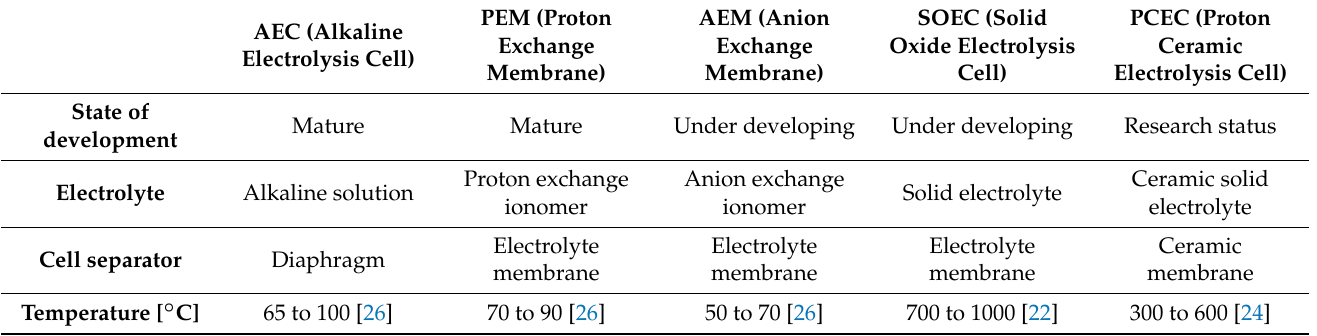
Table 1. Main characteristics of different electrolyzer technologies